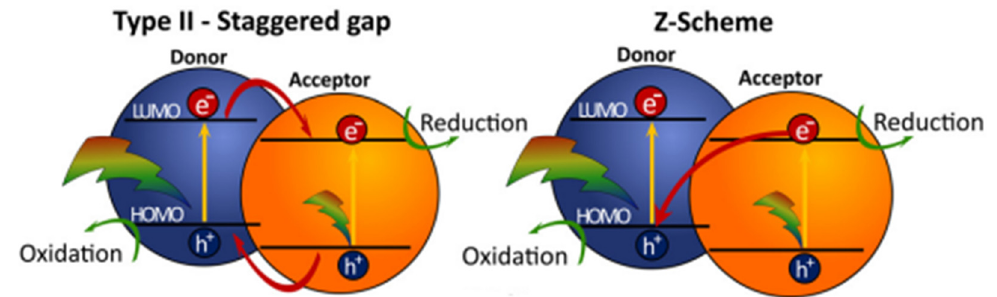
Figure 37. General schematic of a type-II offset to create a heterojunction in a nanocomposite photocatalyst system for hydrogen production. The charge transfer processes are also illustrated that are typical of a Z-scheme photocatalytic system. [Figure from ref. [157] under CC-BY 3.0 International License].